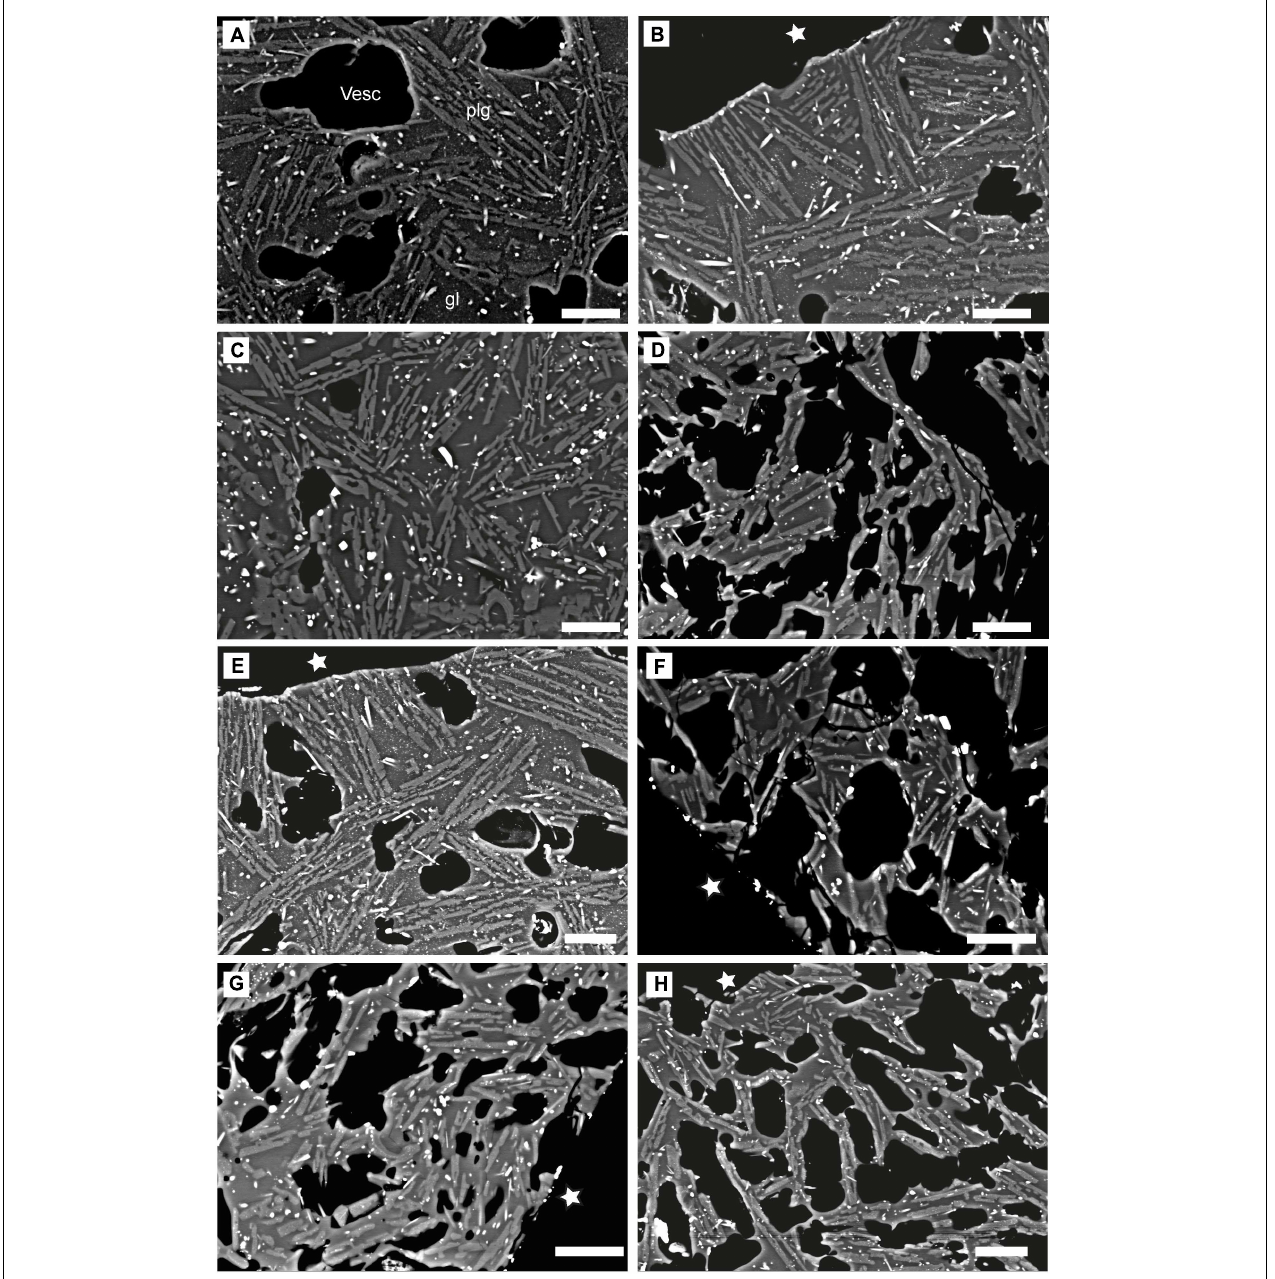
FIGURE 1 | Plagioclase textures observed in experiments. (A) Baseline experiment held for 24 h at 50 MPa. (B,E) Experiment continuously decompressed from 50 to 10 MPa at 0.026 MPa s − 1 . (C) Re-compression to 110 MPa. (D) Experiment after decompressing from 110 MPa to 10 MPa. (F) Top, (G) middle, and (H) bottom sections, respectively, of dynamic compression experiment 9SP350-10. Stars mark the boundary of the quenched experiment with the capsule wall. Vesicles (vesc), plagioclase microlites (plg), and glass are denoted in image (A) . The white pixels are Fe-oxides. Scale bar corresponds to 10 µ m and applies to all eight